Question: Summarize what this figure shows in one sentence.
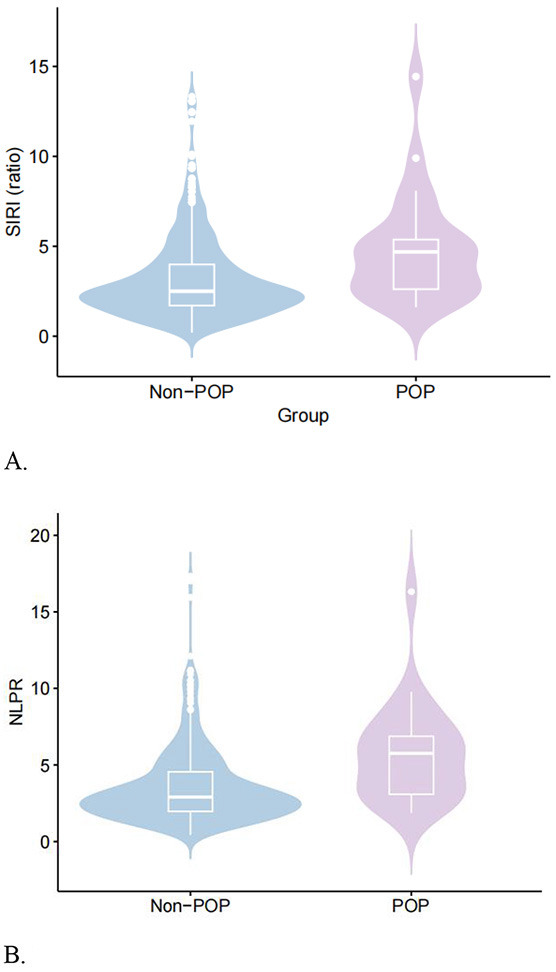
Answer: Violin plots of SIRI (A) and NLPR (B) in the non-POP and POP groups. (A) The SIRI of the POP group was higher than that of the non-POP group ( P < 0.001); (B) The NLPR of the POP group was higher than that of the non-POP group ( P < 0.001).